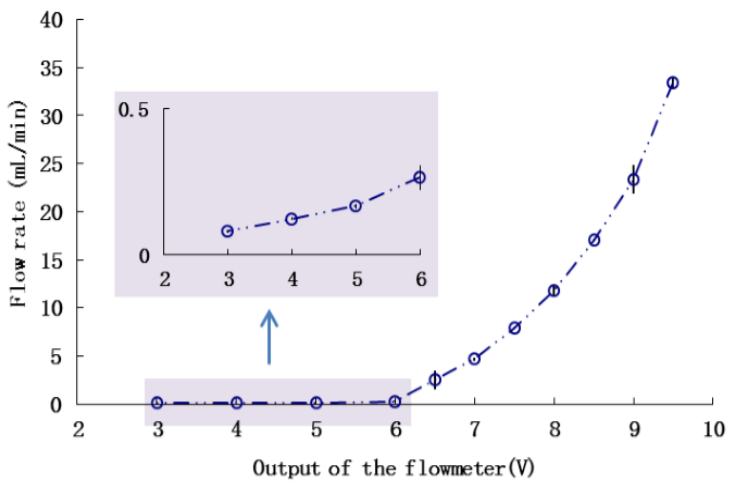
Figure 7. Calibration of the flowmeter.